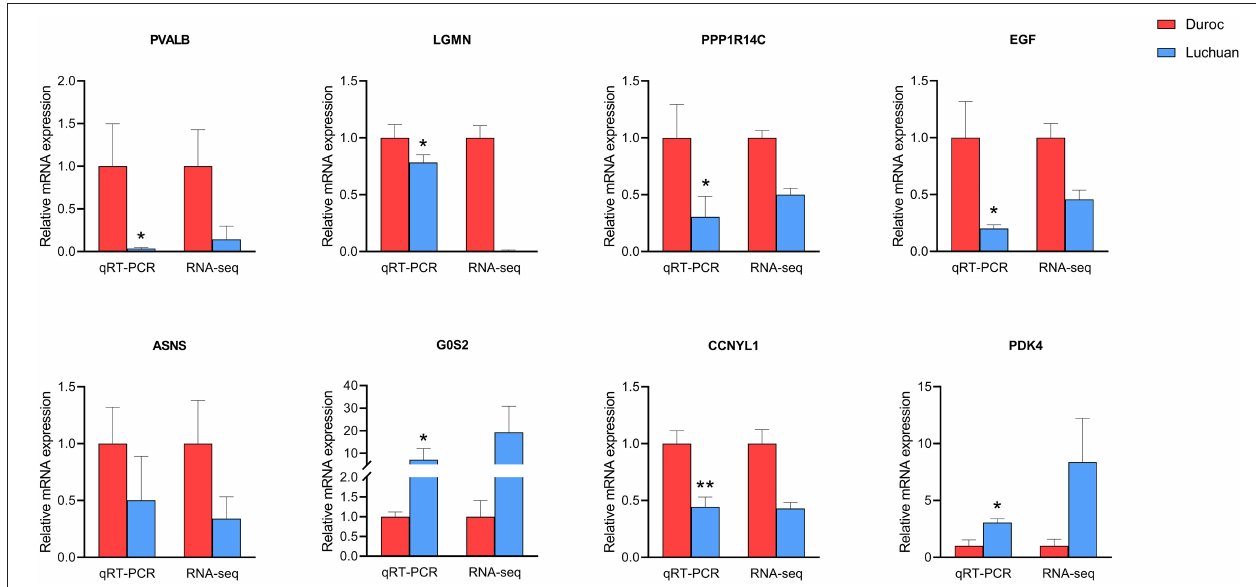
FIGURE 6 | Verification of RNA-seq data by qRT-PCR. The left y -axis represents the relative expression level as determined by qRT-PCR, and the right y -axis represents the FPKM value as determined by RNA-seq. All data represent the average value of three biological replicates. The error line represents three repeated standard errors, and all data are normalized. * P < 0.05, ** P <